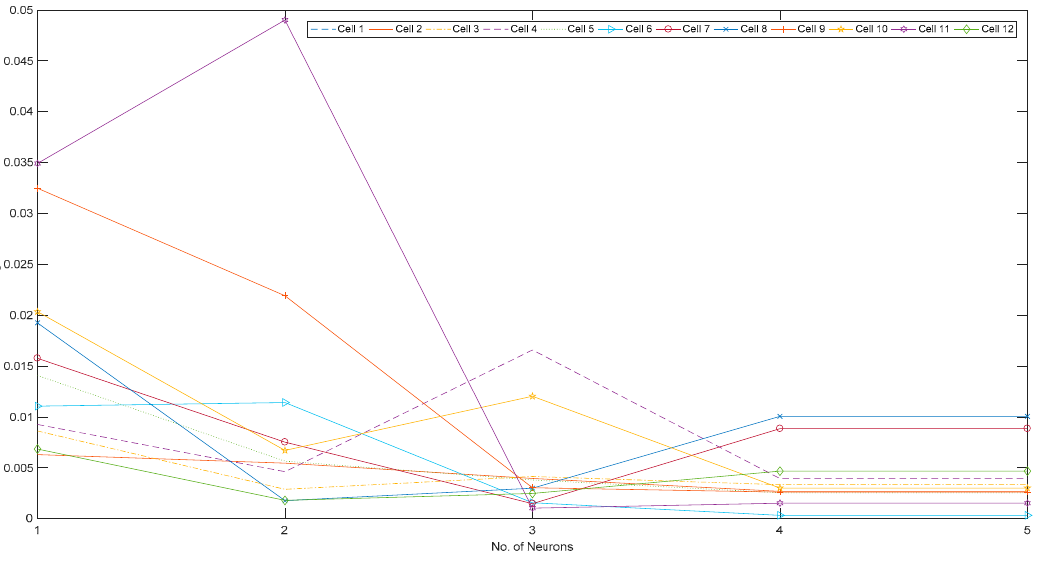
Figure 21. Training time for a 12-cell battery at 25 °C for five neurons (N0 = 200, block range = 847, sinusoidal activation function).